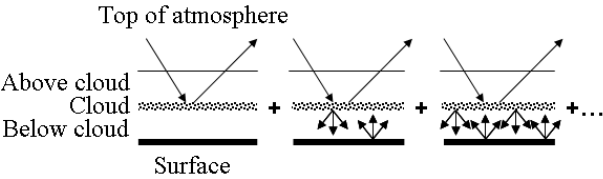
Fig. 1. Figure illustrating the multiple reflections between cloud and